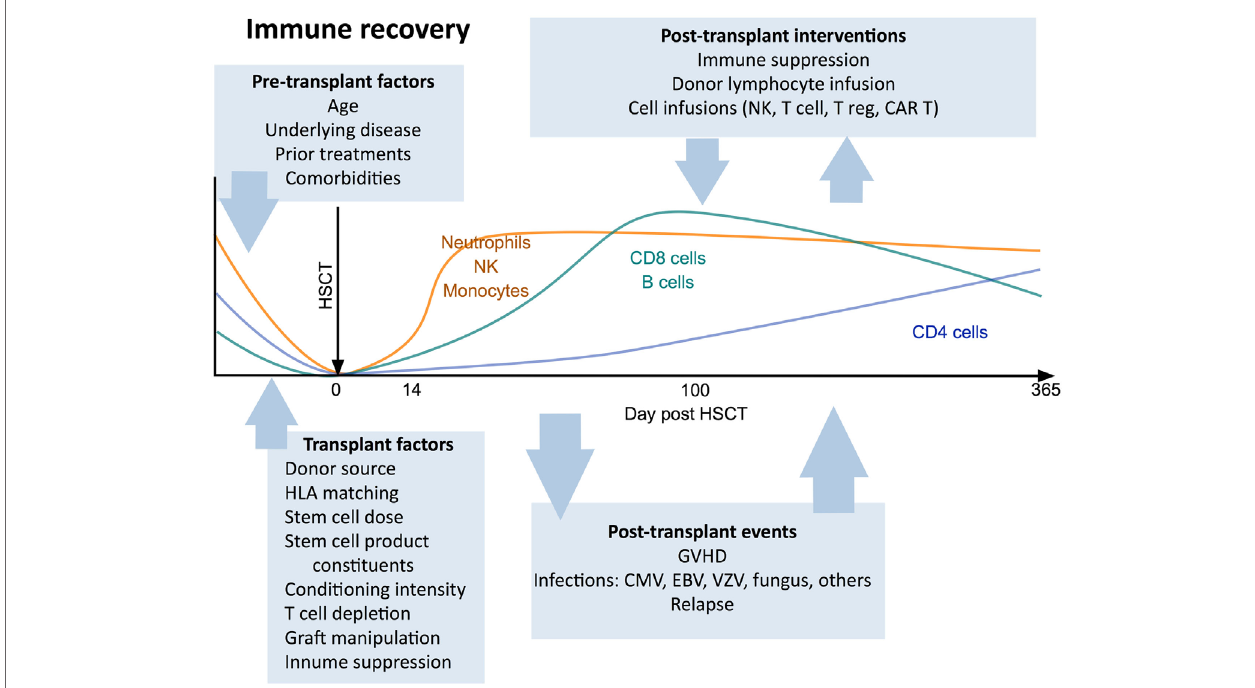
FiGURe 1 | Canonical view of immune reconstitution. In the first 12 months after allogeneic hematopoietic stem cell transplantation the major cell subsets follow a predictable pattern of recovery under the influence of a large number of factors including patient baseline characteristics, transplant factors, post-transplant events, and therapeutic interventions. Abbreviations: CAR T, chimeric antigen receptor T cells; GvHD, graft-versus-host disease; CMV, cytomegalovirus; VZV, varicella zoster virus; EBV, Epstein–Barr